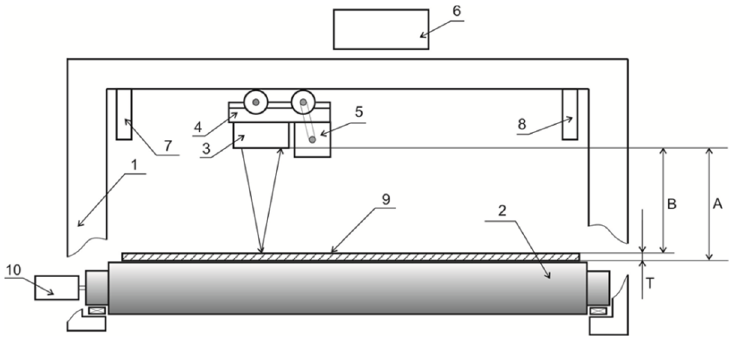
Figure 2. Design of an automatic control measuring system for the 6 m wide HDPE/LDPE polymer geomembrane. 1—frame; 2—support roller; 3—laser sensor; 4—carriage; 5—stepper motor; 6—con- trol unit; 7.8—switches; 9—moving geomembrane; 10—rotation angle sensor.